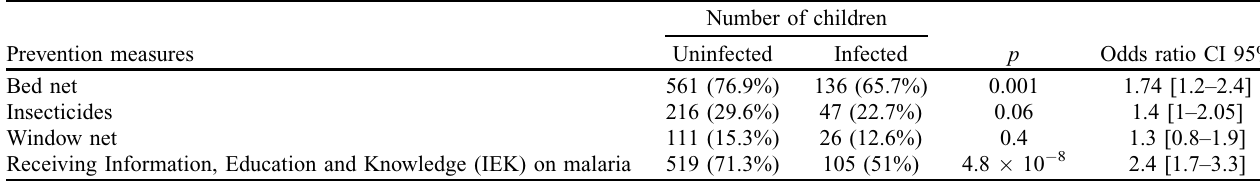
Table 5. Preventive measures between malaria infected and uninfected